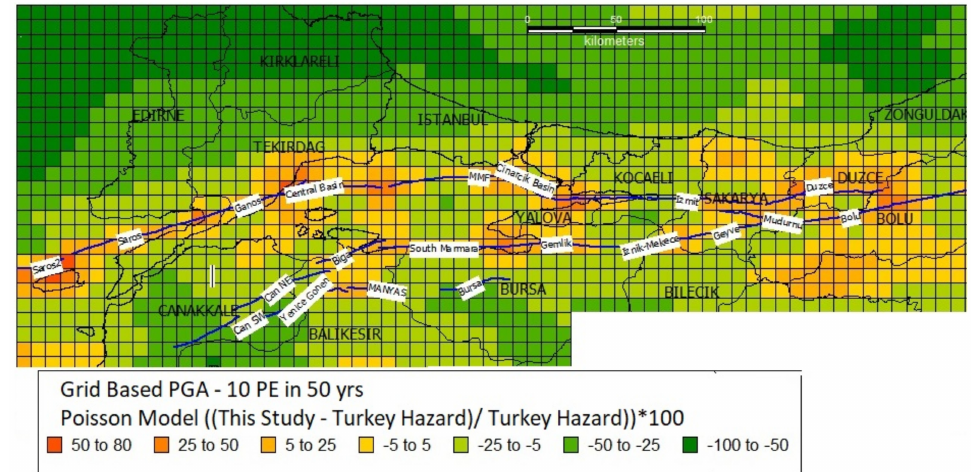
Figure 28. Di ff erence map of the Poisson model results from this study and the new Turkish seismic hazard model. It represents the ratio between the mean PGA seismic hazard at {[ PSHA thisstudy − PSHA TurkeyHazard ] / PSHA TurkeyHazard } × 100, Turkey Hazard and this study (%10 in 50 yrs.) calculated using the background seismicity and individual fault segments. In red: positive amplifications. In green: negative